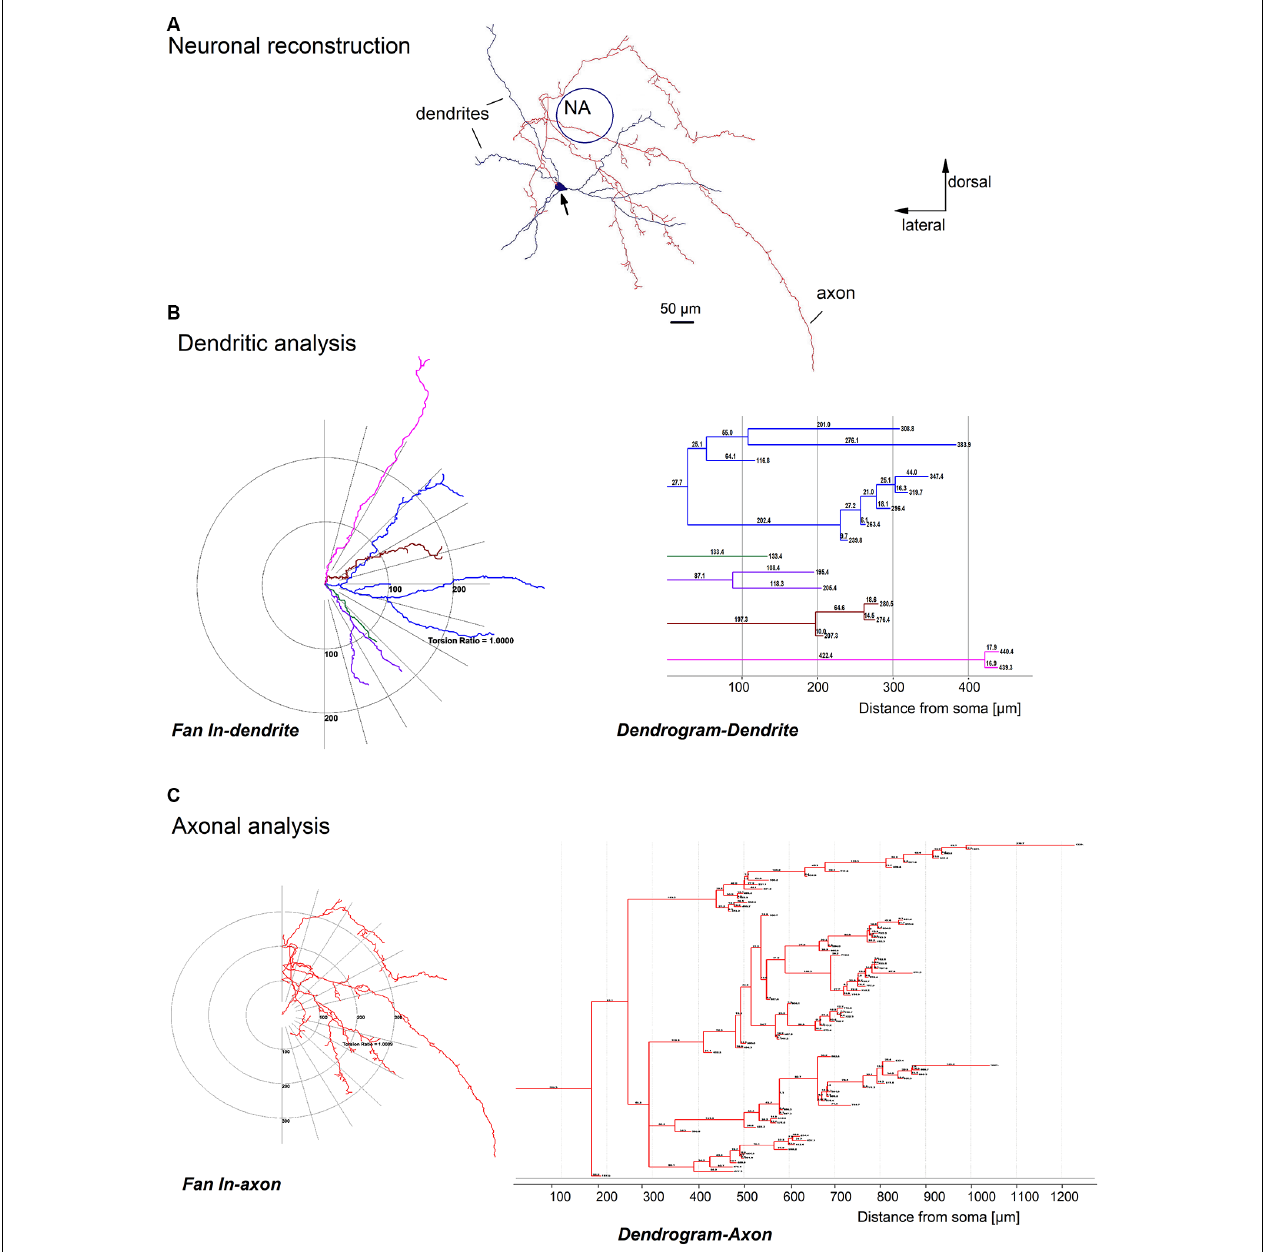
FIGURE 2 | Quantitative analysis of a biocytin-labeled glycinergic preBötC neuron. Panel (A) shows an example of a glycinergic preBötC neuron, reconstructed with the help of Neurolucida software, showing the soma (arrow), dendrites (blue) and axons (red). Panels (B,C) are schematic projections of the dendrites ( fan in dendrite) and axons ( fan in axon) of the neuron illustrated in (A) . Note that all dendrites (B) and axon collaterals (C) on the left diagrams are rotated over to one side and projected on the half-plane. The distances to the soma for each dendrite (B) and axonal collateral (C) were quantified and plotted as dendrograms for the dendrite and axon on the